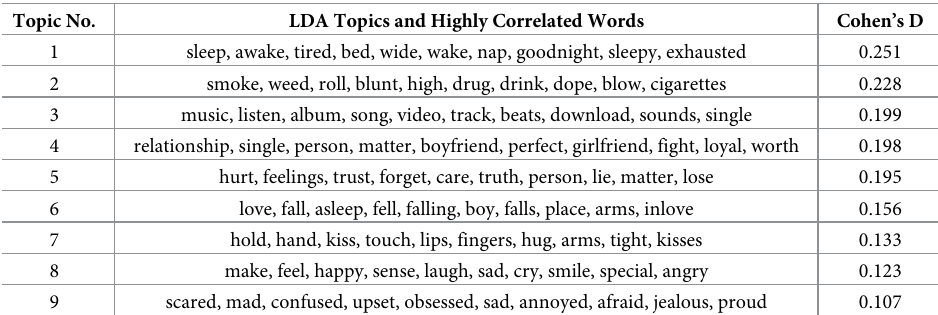
Table 4. Results from LDA analysis for gender: Female. Topic